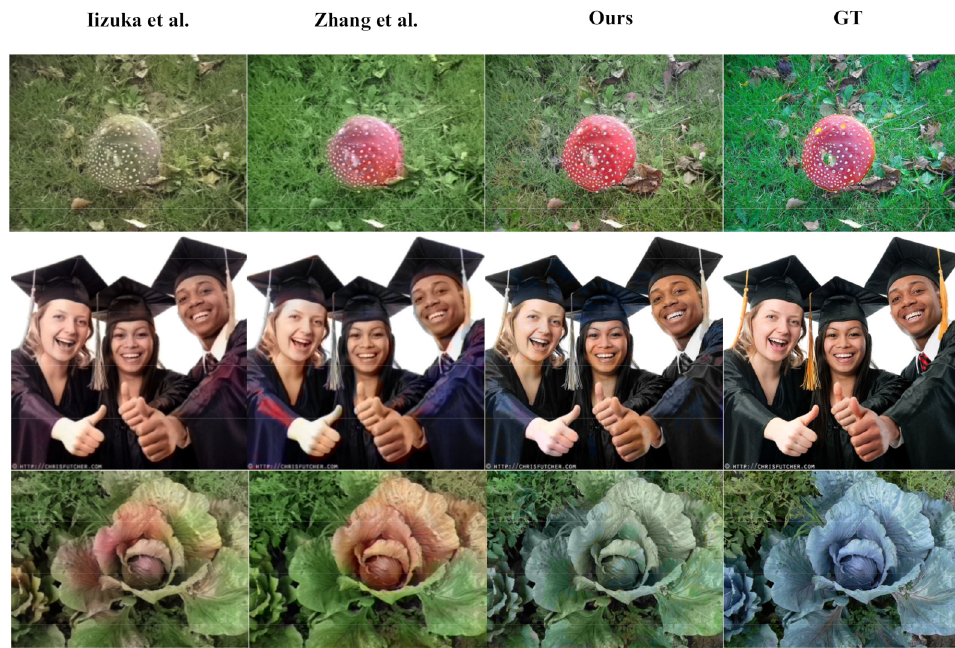
Figure 1. Problems with the current colorization networks. Using regression loss functions (such as Iizuka et al. [11]) results in a brownish, unsaturated result. Using classification loss functions (such as Zhang et al. [22]) results in color